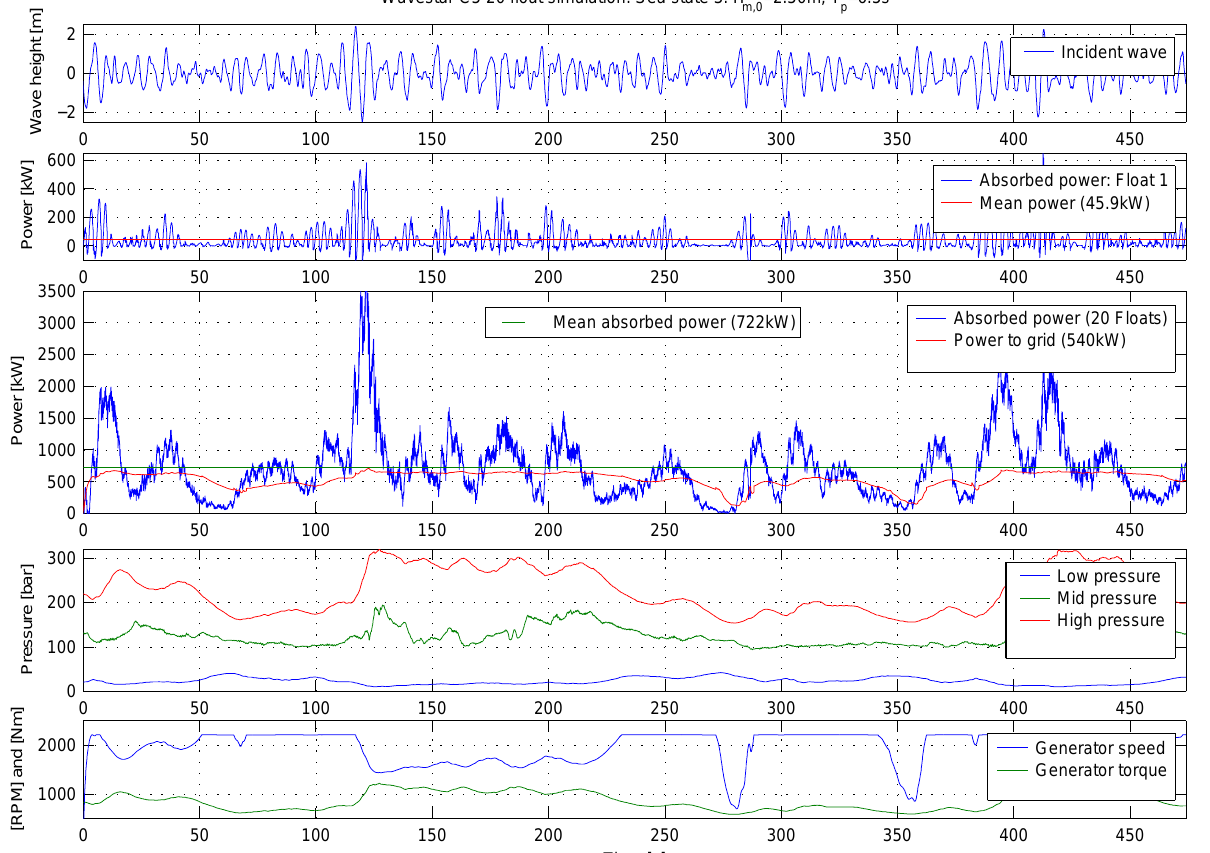
= 2.50 m, T = 6.5 m,0 p